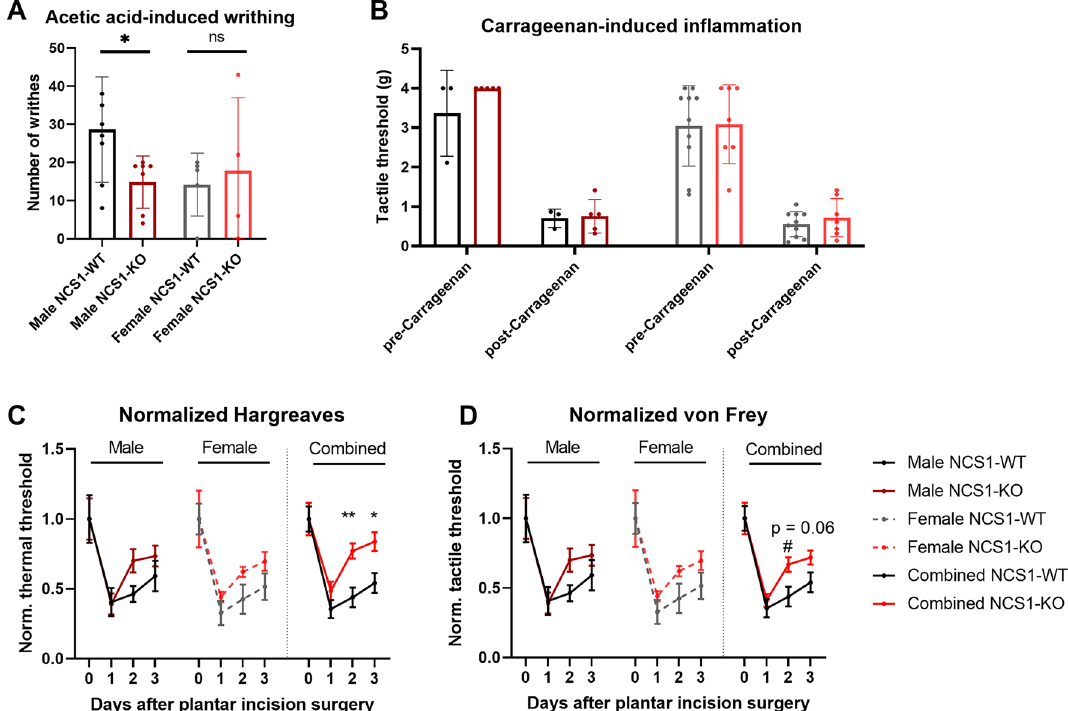
Figure 2. NCS1-WT and -KO mice exhibit differences in pain sensation. ( A ) Male NCS1-KO mice (n = 7) exhibited fewer writhes compared to -WT controls (n = 8) after dilute acetic-acid injection (unpaired t-test, p = 0.03), whereas female mice (NCS1-KO: n = 4, NCS1-WT: n = 5) showed no difference between genotypes (unpaired t-test, p = 0.7176). ( B ) No differences were observed between NCS1-KO (male NCS1-KO: n = 5, female NCS1-KO: n = 7) and -WT mice (male NCS1-WT: n = 3, female NCS1-WT: n = 10) in the Carrageenan inflammatory pain assay [2-way ANOVA (male), Factor genotype, p = 0.20; 2-way ANOVA (female), Factor genotype, p = 0.73]. ( C ) The normalized Hargraves assay shows differences between NCS1-KO (female NCS1-KO: n = 4, male NCS1-KO: n = 6) and -WT mice (female NCS1-WT: n = 8, male NCS1-WT: n = 4) 2 and 3 days after plantar incision surgery (2-way ANOVA, Factor genotype, p = 0.03, followed by multiple comparison test with Sidak’s correction, day 2, p = 0.01, day 3, p = 0.02). ( D ) The normalized von Frey assay indicates a difference between NCS1-KO (male NCS1-KO: n = 6, female NCS1-KO: n = 4) and -WT (male NCS1-WT: n = 8, female NCS1-KO: n = 4) 2 days after plantar incision surgery (2-way ANOVA, Factor genotype, p = 0.16, followed by multiple comparison test with Sidak’s correction, day 2, p = 0.06). Line graphs show mean ± SEM, bar graphs show mean ±